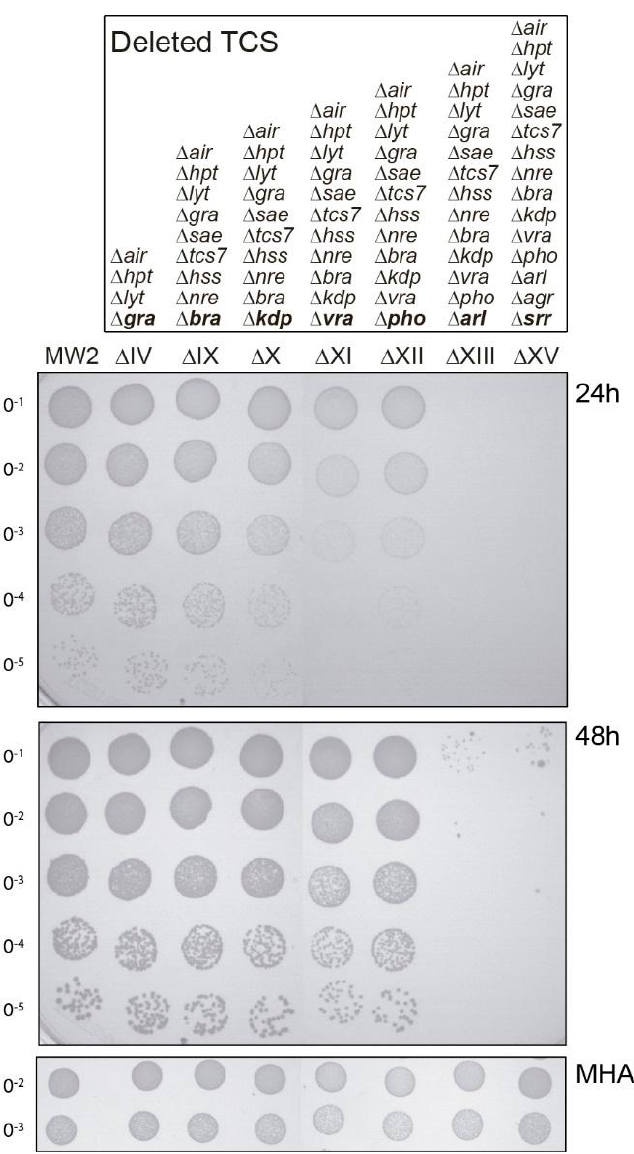
Figure 1. Effect of TCS deletions on enhanced ceftaroline susceptibility. Spot plating population analysis profiles (Spot PAP) of MW2 and their corresponding Δ IV, Δ IX, Δ X, Δ XI, Δ XII, Δ XIII, and Δ XV mutant strains on MHA plates containing ceftaroline. The deleted TCS in each strain is indicated in bold. Upper panels correspond to MHA plates containing 0.25 µg/mL of ceftaroline at 24 and 48 h of incubation, respectively. The lower panel corresponds to control MHA plates without antibiotics. Spot serial 10-fold dilutions are indicated at the left margin. The first spot 10 µL corresponds to 1.5 × 10 5 colony forming units (CFU).